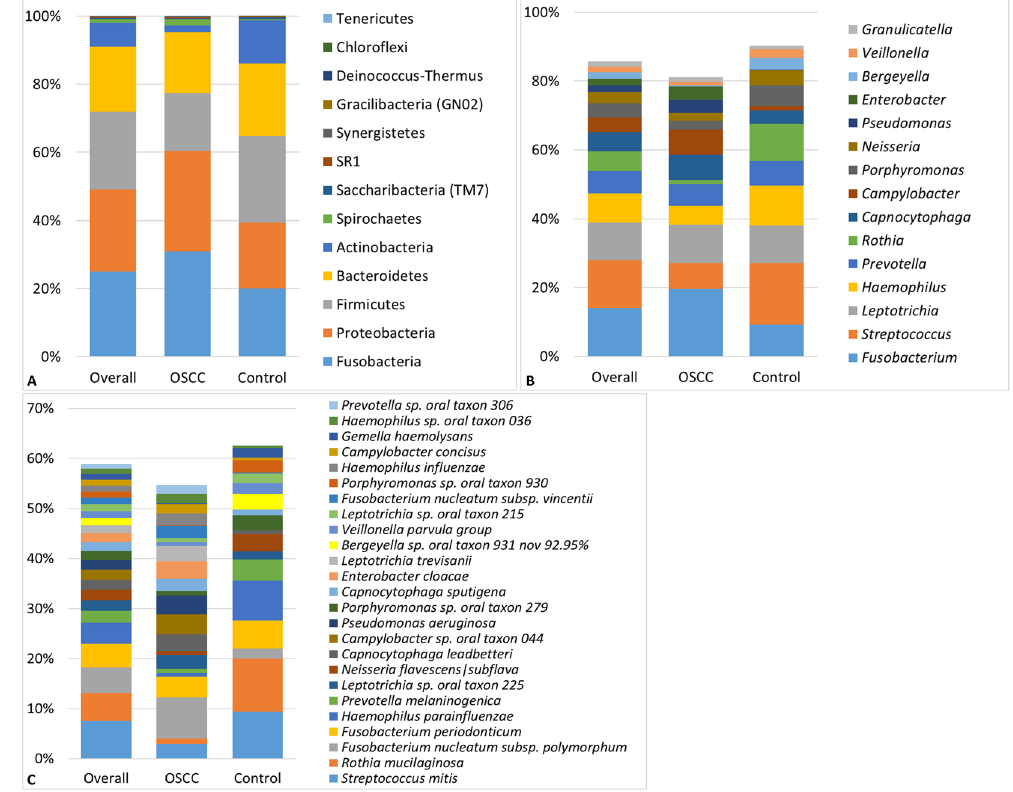
Figure 1. Bacteriome profile. Stacked bars showing the distribution of phyla, top 15 genera and top 25 species detected in the study population and groups.